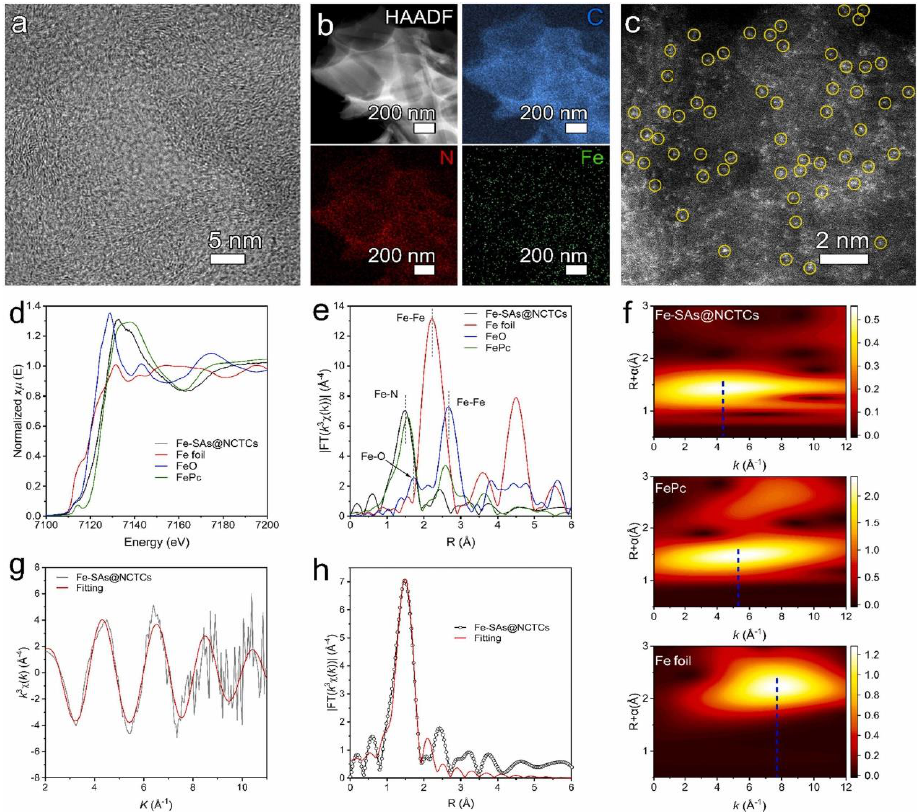
Figure 2. ( a ) HR − TEM, ( b ) EDX elemental mapping image, and ( c ) AC − HAADF − STEM image of Fe − SAs@NCTCs. ( d ) The Fe − K-edge XANES spectra and ( e ) Fourier transform of the Fe − SAs@NCTCs, Fe foil, FeO, and FePc in the Fe − K − edge EXAFS spectra. ( f ) WT − EXAFS plots of Fe − SAs@NCTCs, FePc, and Fe foil, respectively. ( g , h ) First − shell (Fe − N) fits to the FT − EXAFS spectra of Fe − SAs@NCTCs in K and R space, respectively. (Copyright 2022, Elsevier) (Reprinted with permission from [53]. Copyright 2022, Elsevier).